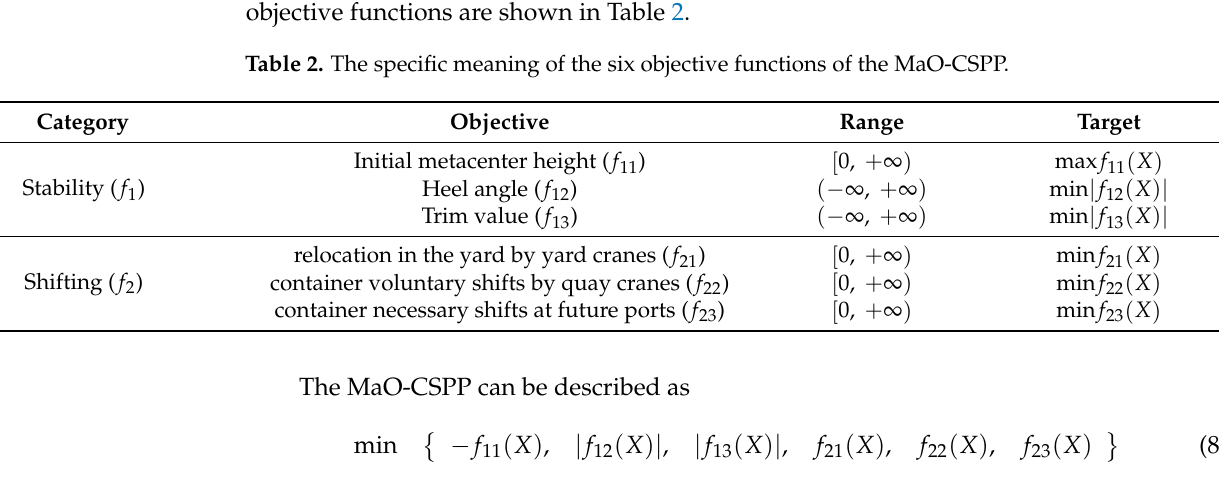
Figure 4. Example of necessary container shifts.